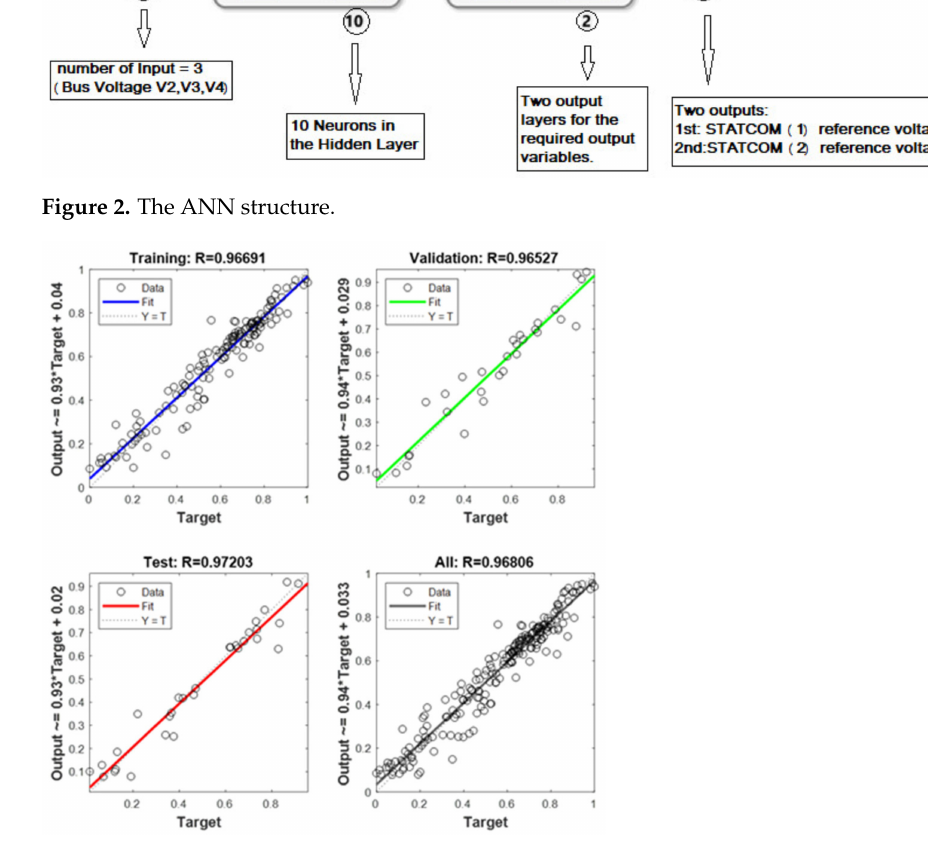
Figure 3. Performance of ANN training in terms of regression